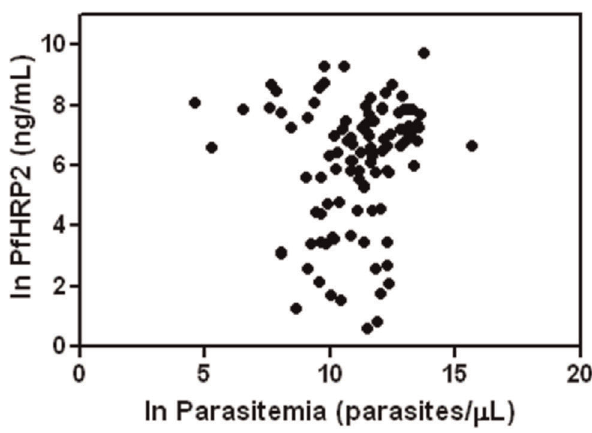
Figure 2. Lack of correlation between plasma PfHRP-2 and peripheral blood parasitemia in children with uncomplicated and cerebral malaria.